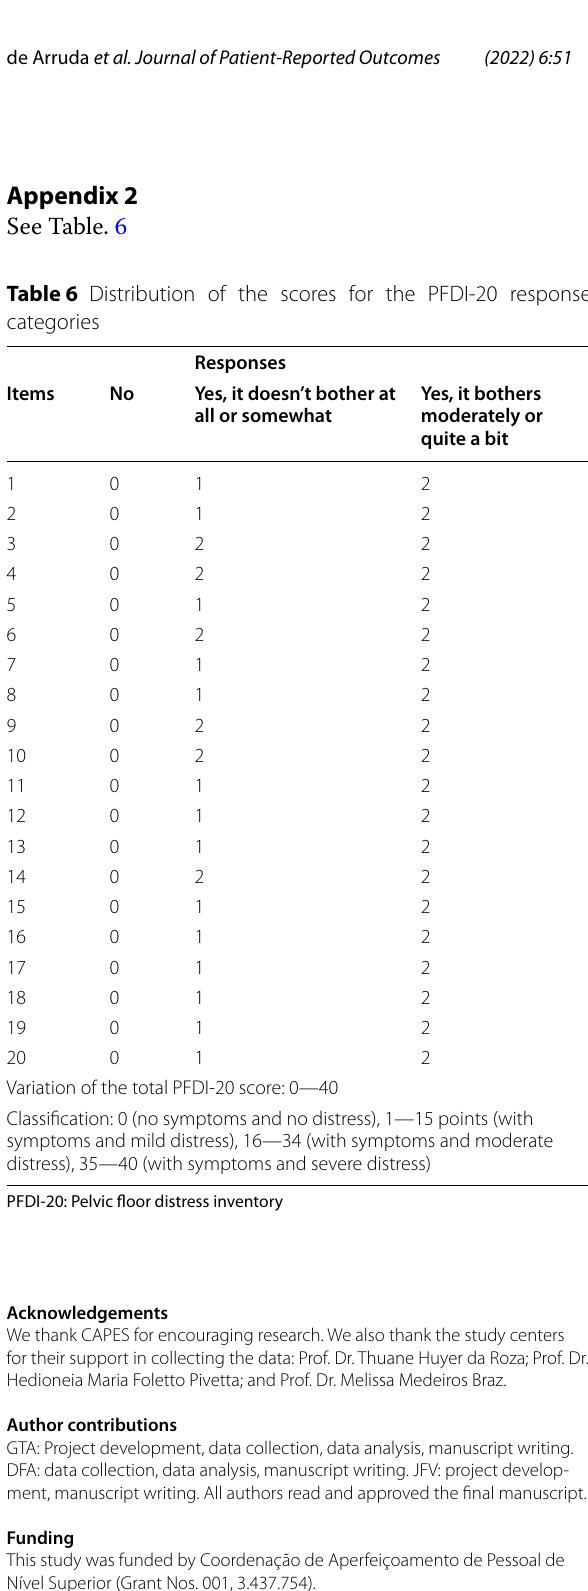
Table 6 Distribution of the scores for the PFDI-20 response categories